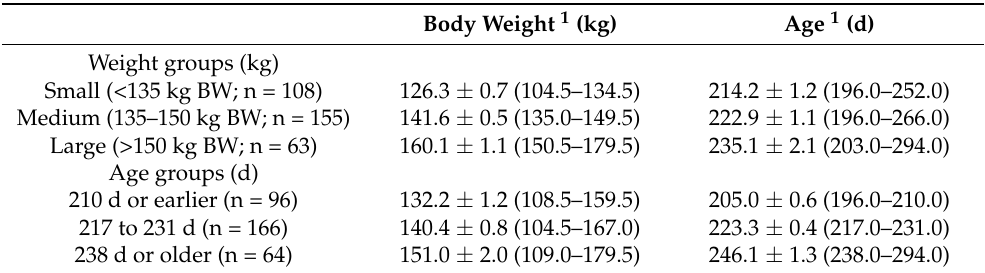
Table 1. Descriptive statistics of gilts according to body weight (BW) and age at first service (days from birth to first